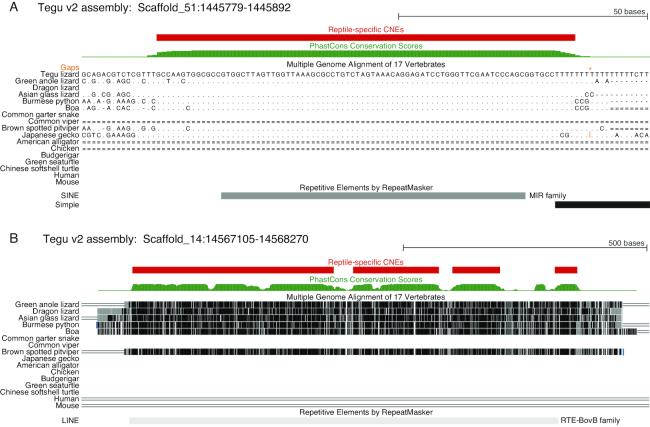
Transposon-derived conserved non-exonic (CNE) squamate-specific elements. (A) A squamate-specific CNE likely originated from the insertion of a short interspersed nuclear element (SINE) belonging to the Mammalian-wide interspersed repeats (MIR) family. The multiple genome alignment shows that this CNE is highly conserved among squamates but does not align to non-reptile species. (B) Several squamate-specific CNEs likely originated from the insertion of a LINE of the RTE-BovB family. This insertion likely happened after the split from the lineage leading to geckos as no sequence aligns to the gecko genome.